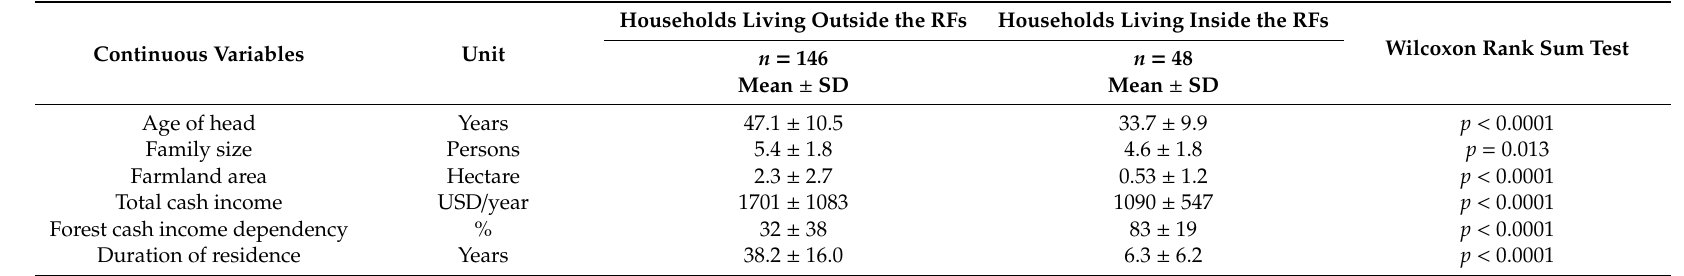
Table 2. Continuous variables of socio-economic characteristics for the sample households.